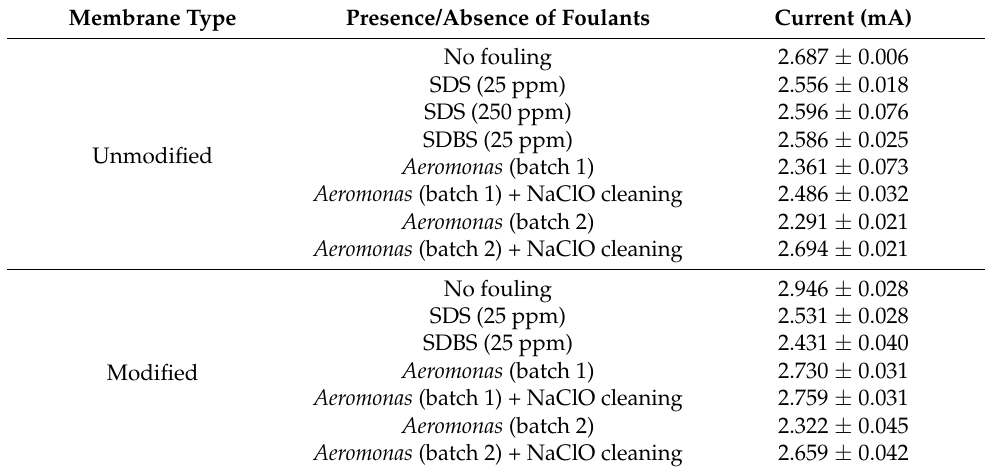
Table 4. Obtained currents at the maximal applied voltage of 0.6 V.